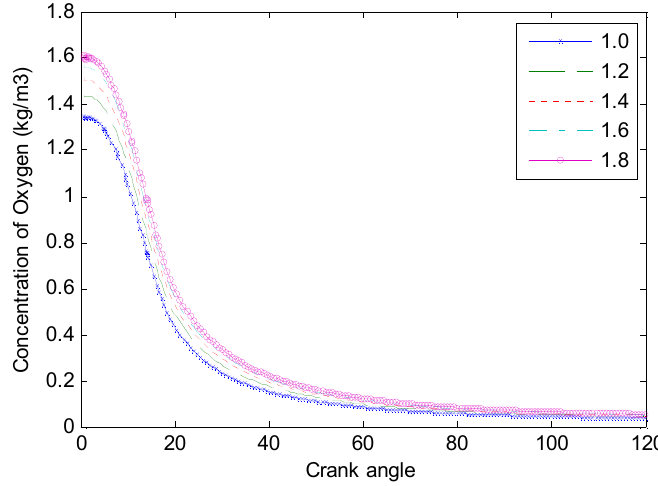
Figure 8. Curves of the value of c o with di ff erent values of ξ